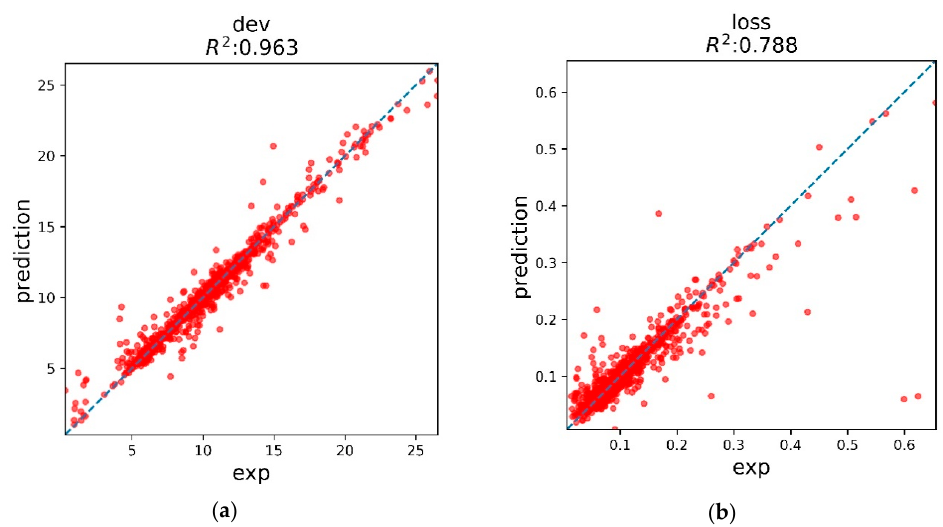
Figure 8. Validation of SVR models on the whole data set: ( a ) deviation angle; ( b ) total pressure loss.